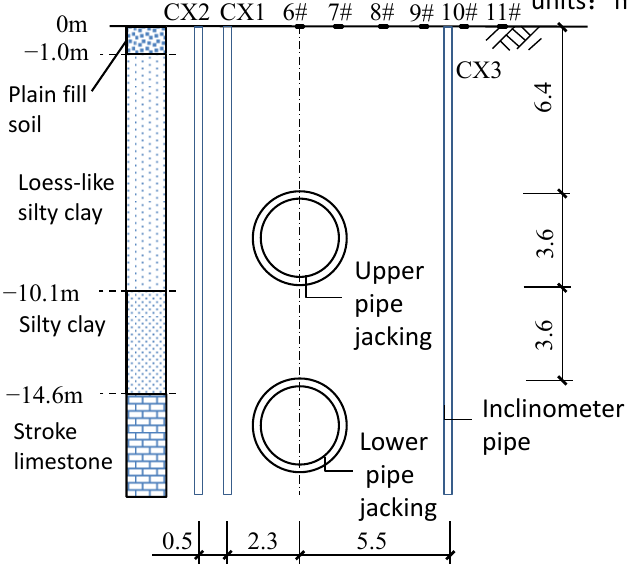
Figure 3. Layout profile of on-site monitoring points.